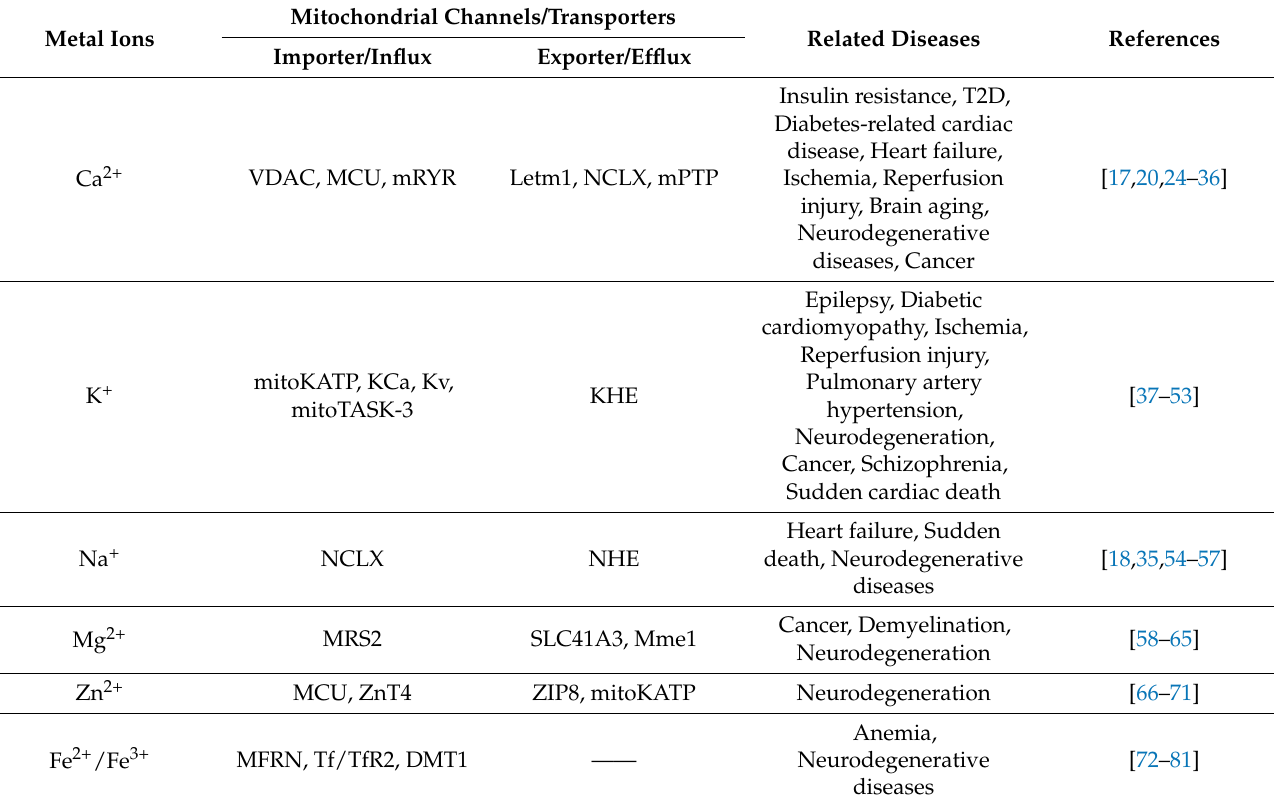
Table 1. Different mitochondrial channels/transporters transport various metal ions, which are closely related to many types of diseases. Most of the discovered mitochondrial metal ion channels/transporters are located on the MIM, but there are a few exceptions, such as VDAC and DMT1 (on the